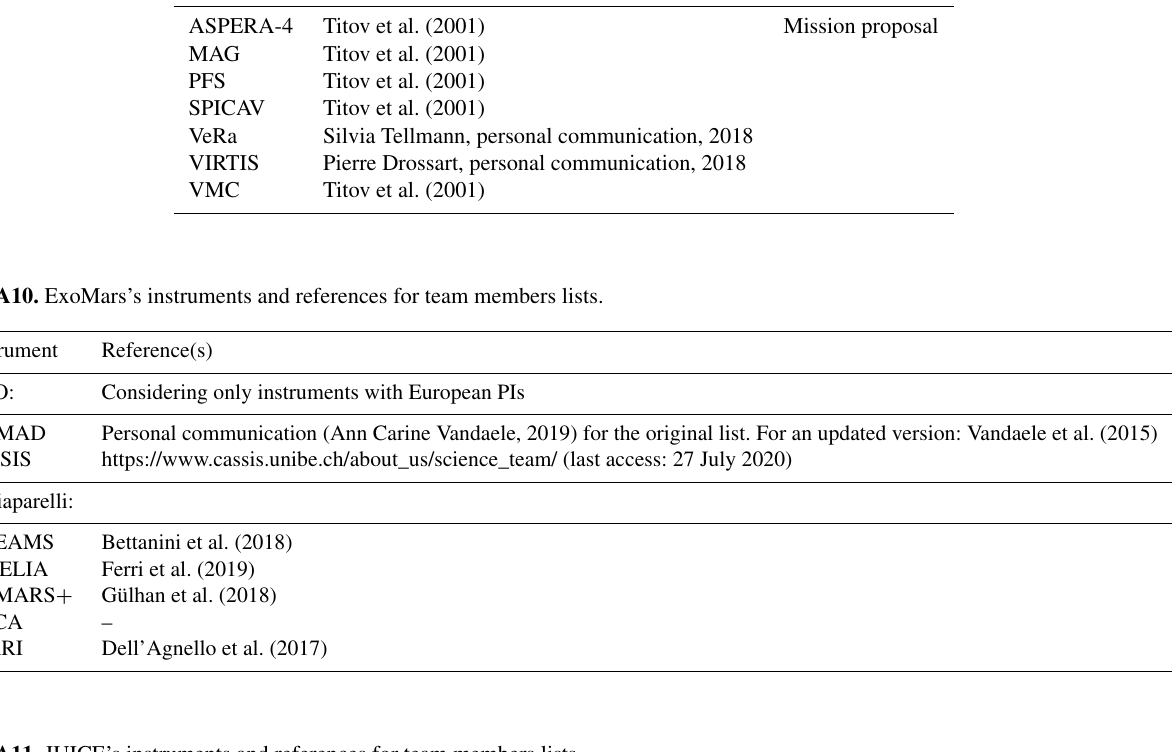
Table A11. JUICE’s instruments and references for team members